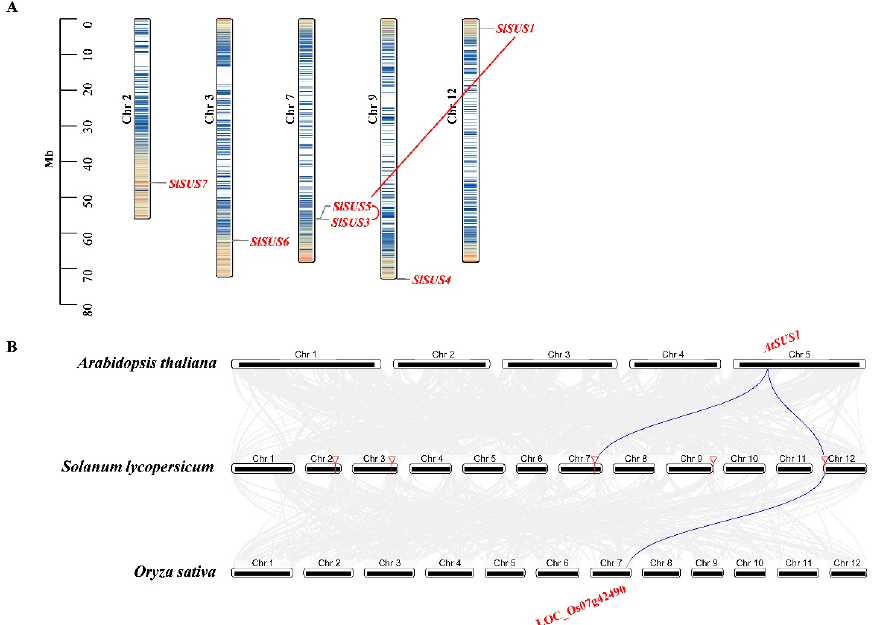
Figure 4. Chromosome localization of tomato SUS genes ( A ) and synteny analysis of SUS genes from tomato ( B ), Arabidopsis and rice. The red arc line indicates tandem duplicated gene pair, and the red straight line indicates segmental duplicated gene pair. Chr, chromosome.